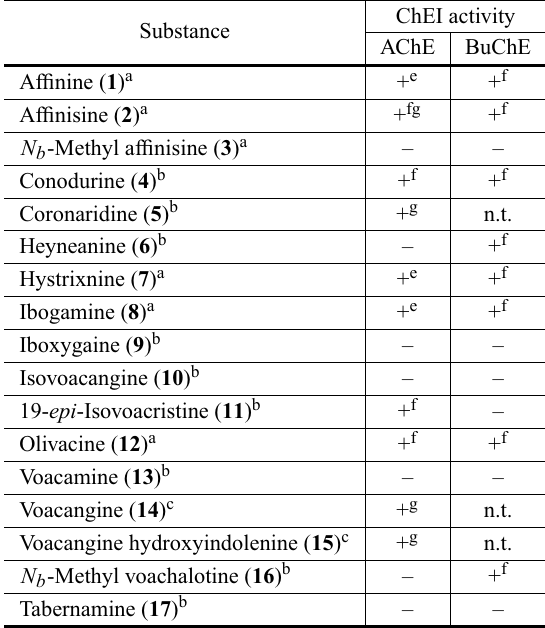
ChE inhibitory activity for indole alkaloids from Tabernaemontana